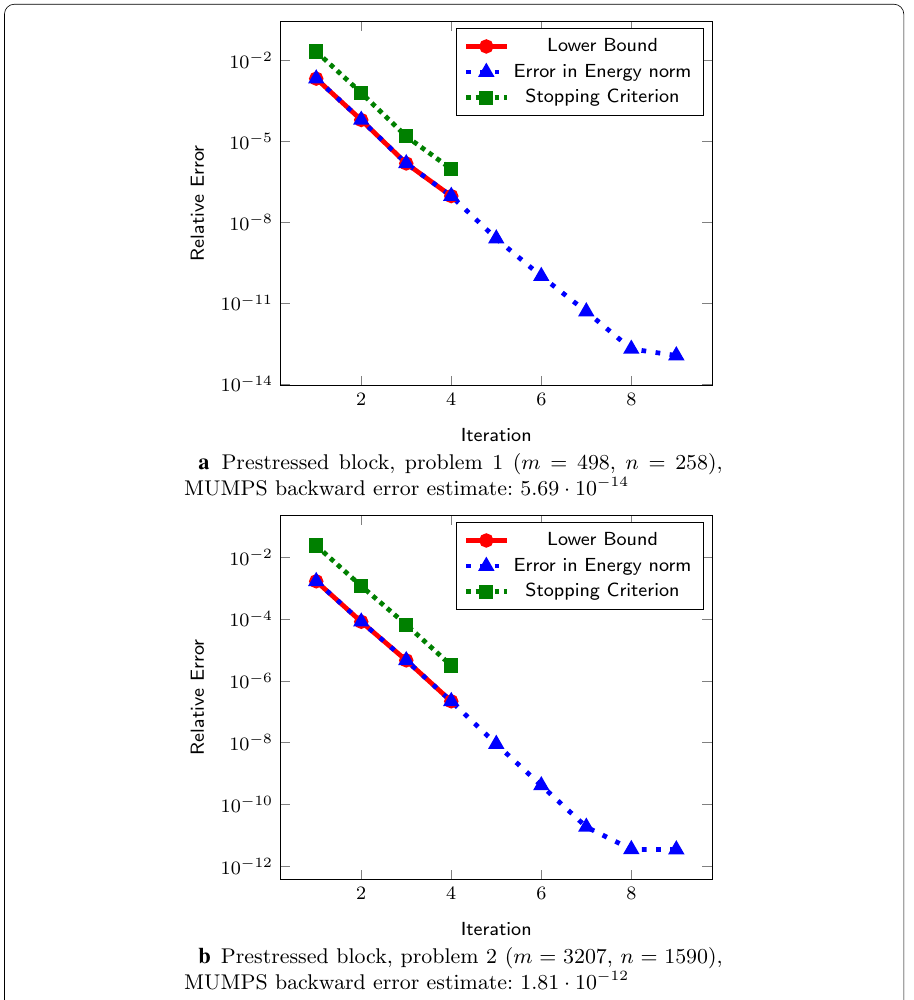
Fig. 7 GKB convergence for Problems 1 and 2 for prestressed block